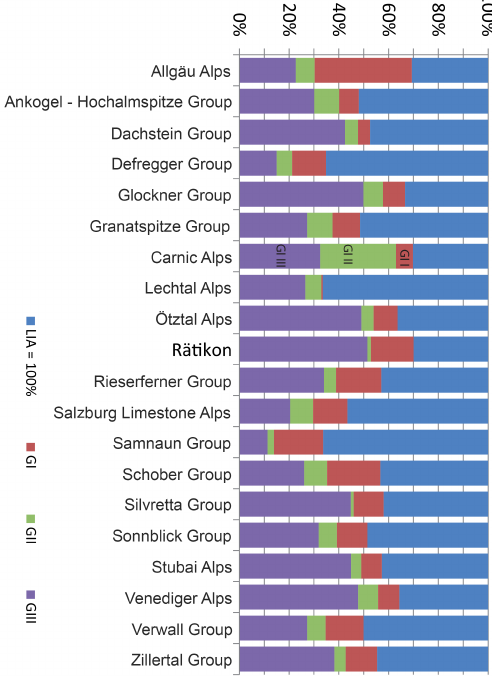
Figure 10. Area changes of specific mountain ranges in percentage of their LIA